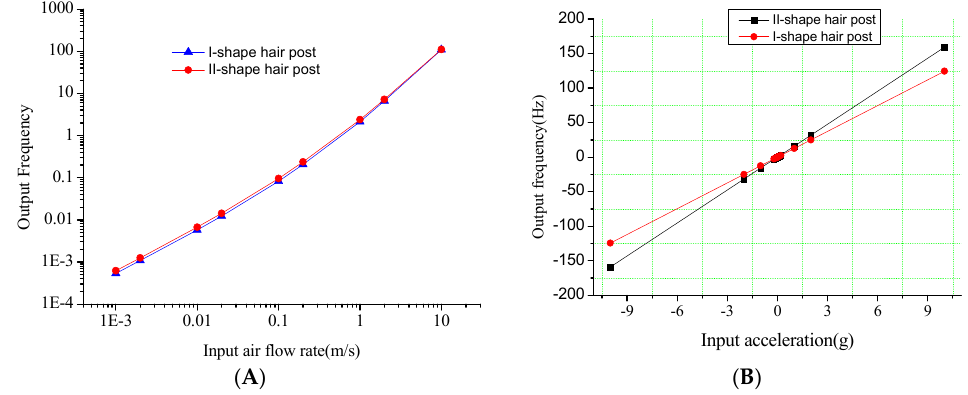
Figure 7. The signal outputs along the x -axis in the hair post structures with different centers of gravity. ( A ) Output frequency versus air flow rate; ( B ) Output frequency versus acceleration. The simulation directivity of hair accelerometer using frequency output at an acceleration input of 1 g is shown in Figure 8.